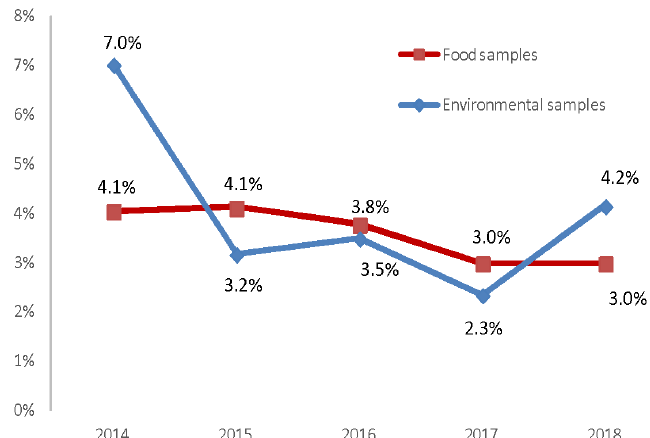
Figure 4. Percentage of non-compliant food and environmental samples.